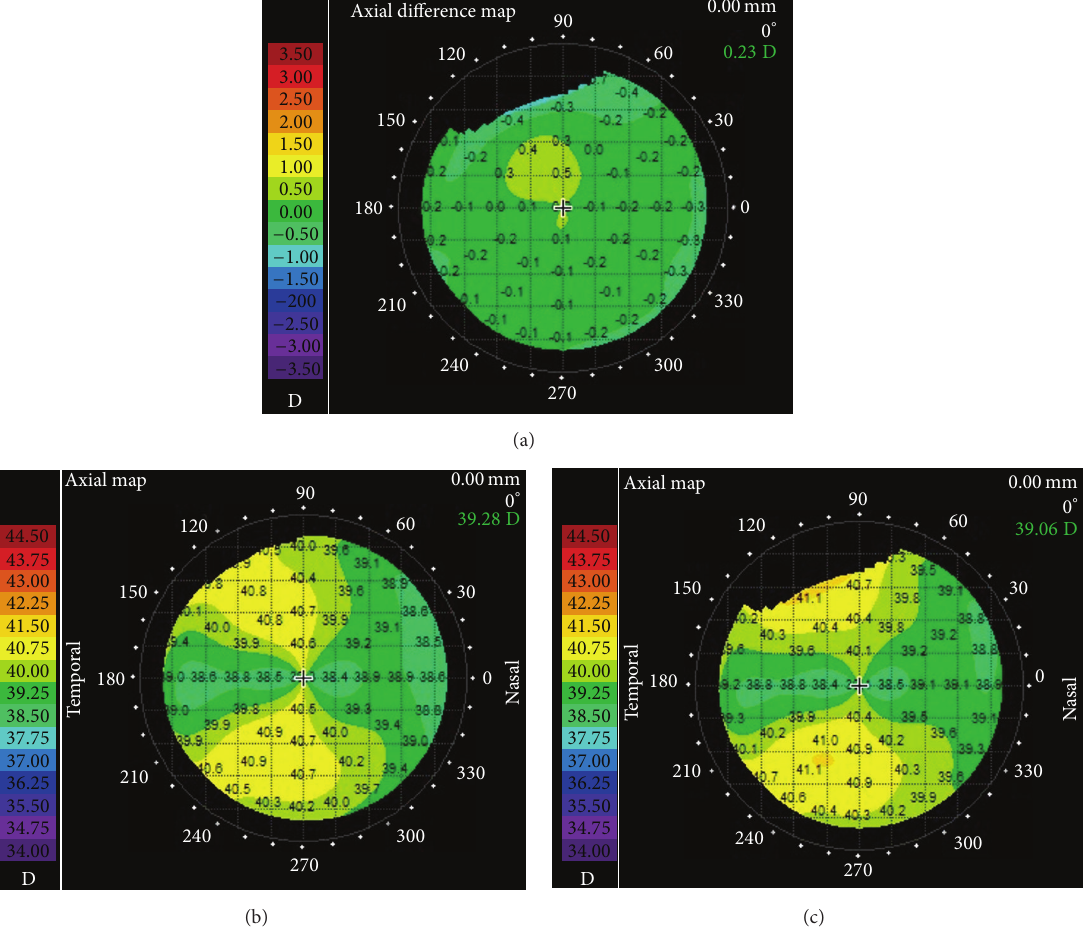
Figure 2: Corneal topography maps preoperatively and one year after the cataract surgery (the map on (b) is preoperative and the map on (c) is one-year postoperative axial map; the map on (a) is the pre- and postoperative axial differential map). Table 1: Biometry readings and target refractions for +21.5 D intraocular lens calculated with three different formulas and manifest refraction one year after